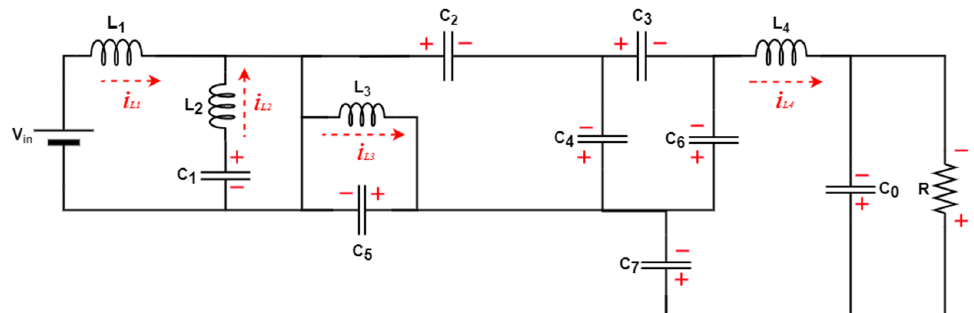
Figure 2. Modified high-gain CUK-based converter during ON mode.